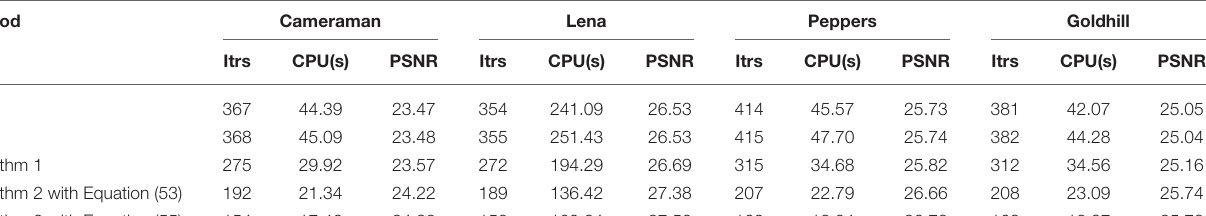
Algorithm 1 Algorithm 2 with Equation (53) Algorithm 2 with Equation (55)